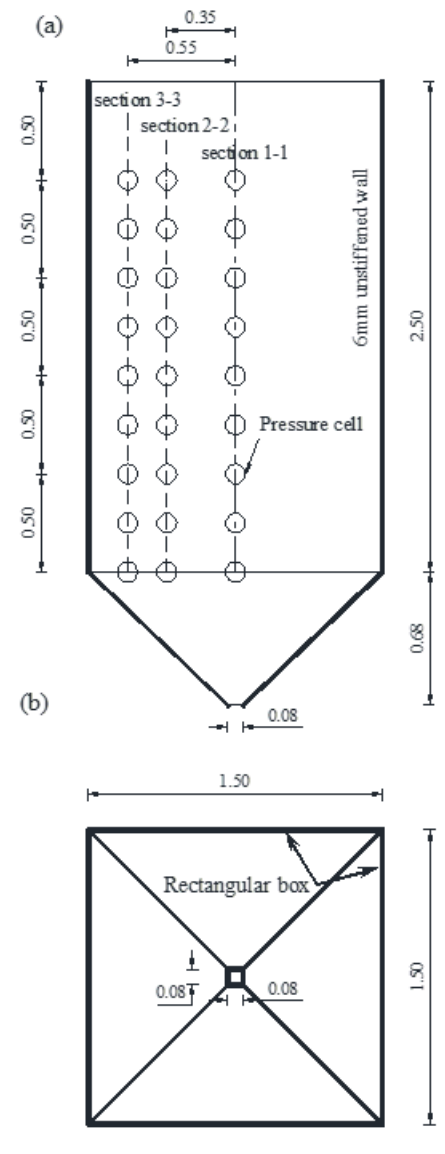
Figure 3. Dimensions of the model silo. ( a ) Elevation view of the model showing pressure cell locations; ( b ) plan view of the model. (All dimensions in meters).